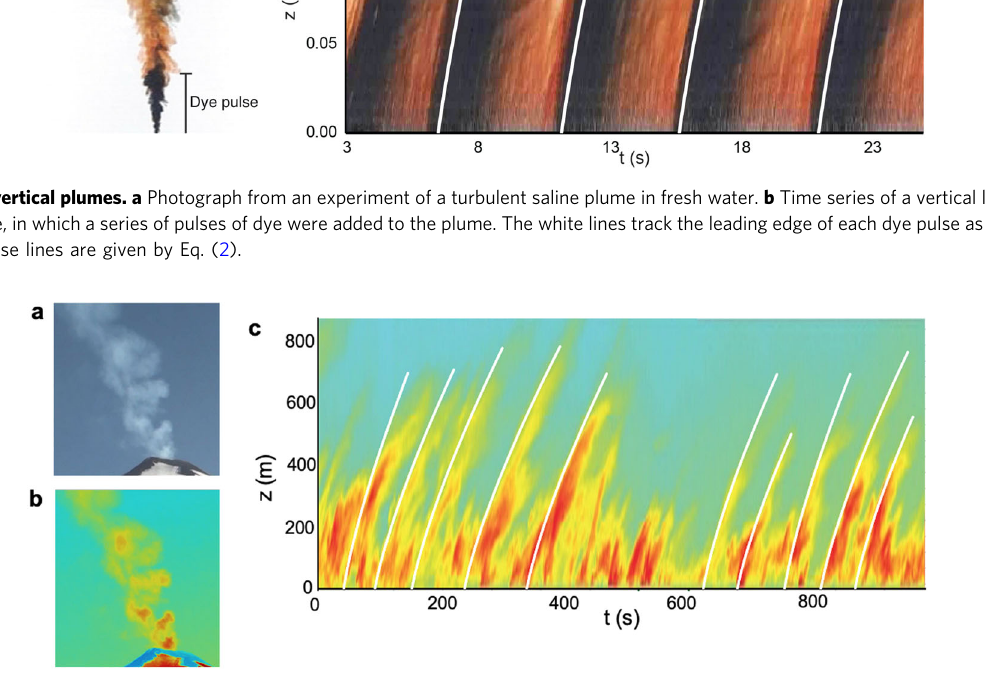
Fig. 3 Volcanic near-vertical plume of Villarrica (2012). a Visible and b false colour images of the Villarrica plume. c Time series of a vertical line through the centre of the Villarrica plume. The white lines illustrating the best fi t to each of the turbulent structures as they move up through the